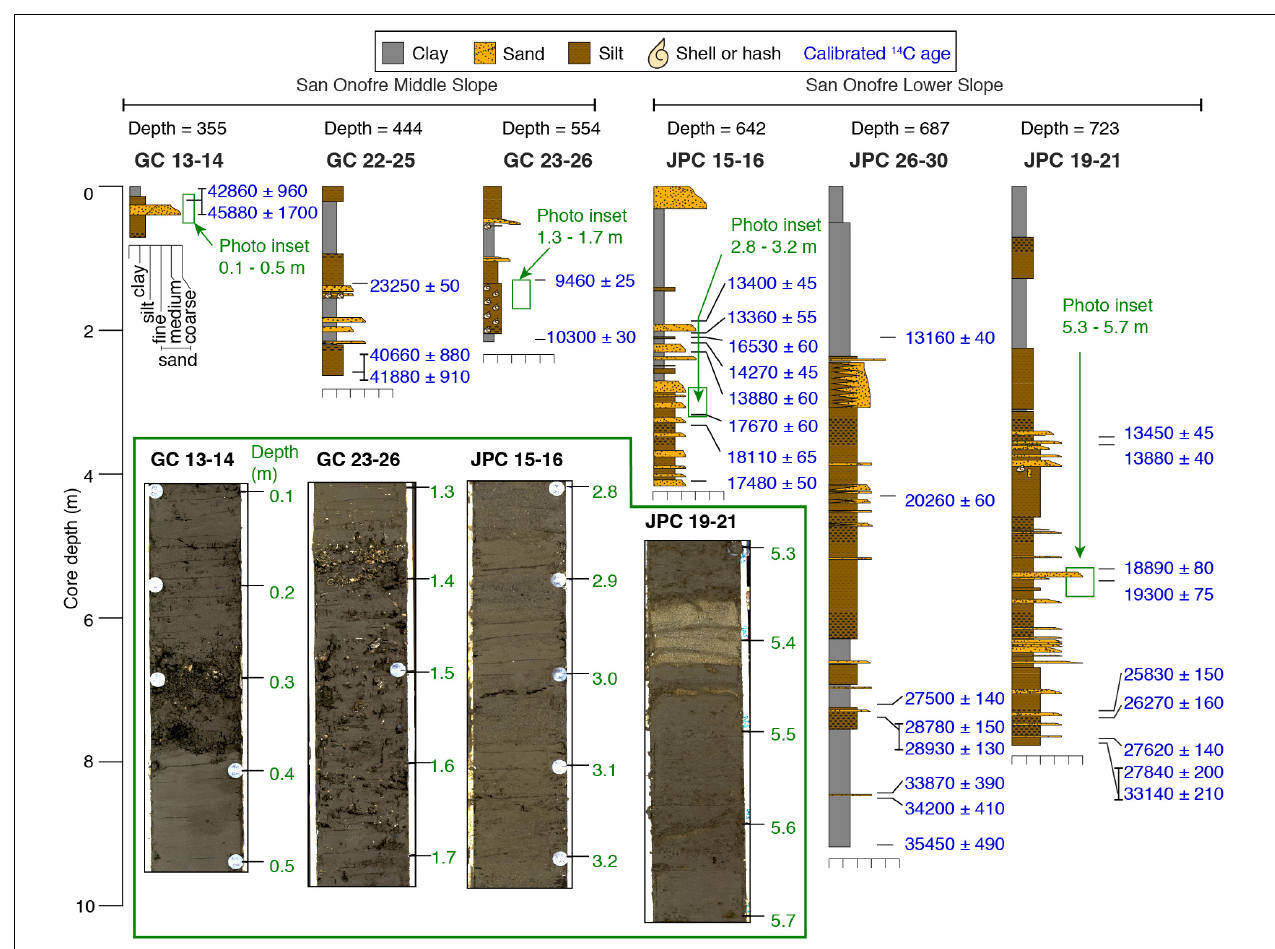
FIGURE 8 | Schematic diagrams of San Onofre cores. Labeled grain size scale is shown under GC 13–14 and unlabeled scales are shown under all other cores. Calibrated radiocarbon ages are shown to the right of the cores. At the bottom left, photo insets of select cores are plotted with their depth. The locations of the photo insets are shown relative to core diagrams by the outlined green